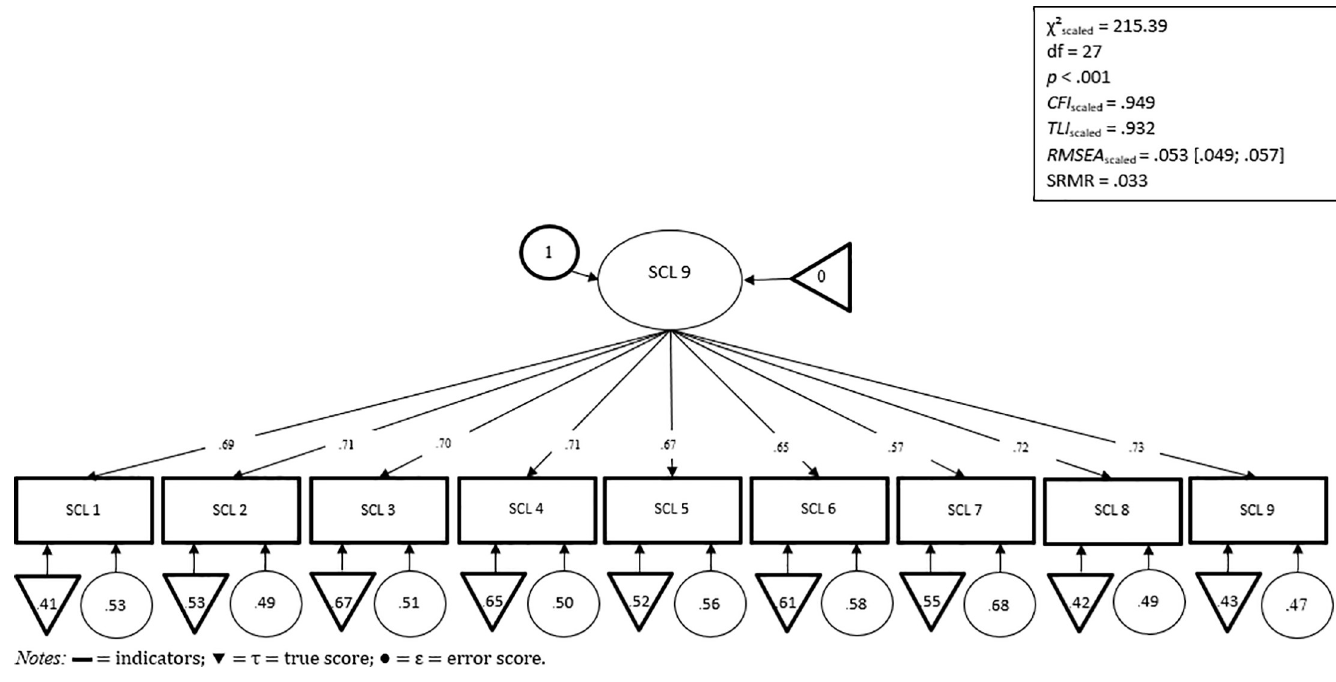
Fig 3. Confirmatory factor analysis